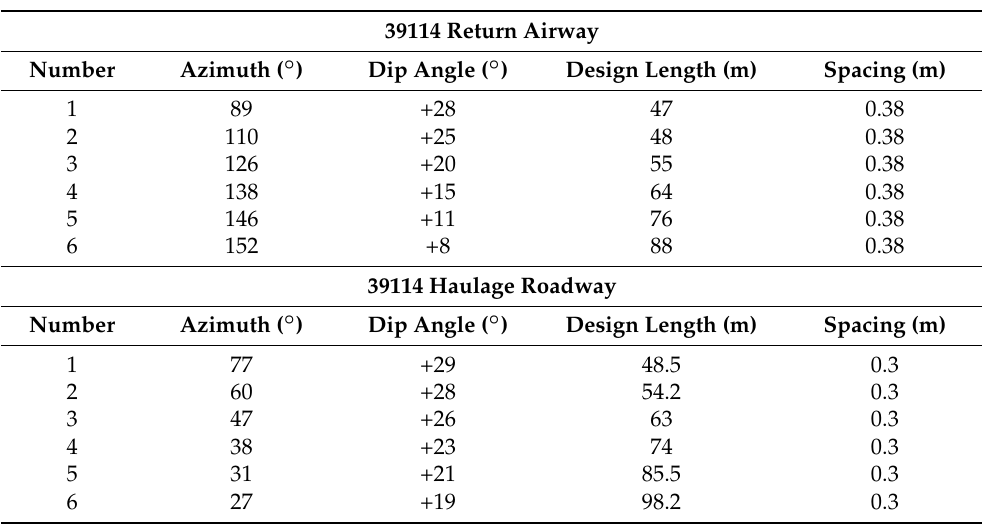
Figure 4. Diagram of the arrangement of pre-drainage boreholes. Table 2. Design parameters of gas pre-drainage